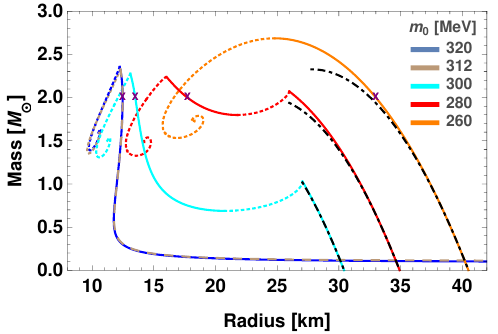
Figure 3 . M - R curves for stellar solutions corresponding to the (cid:12)ve values of m 0 displayed in (cid:12)gure 2. The solid curves represent stable con(cid:12)gurations, whereas the dashed ones illustrate un- stable branches, assuming fast phase transitions, meaning that the phase changes instantaneously when the pressure (cid:13)uctuates around the critical value [66]. Should this not be the case, the stability of some con(cid:12)gurations may change. The dot-dashed black curves (cid:12)nally correspond to the analytic solutions of eq. (3.4). Note that the 312 and 320 MeV curves lie practically on top of each